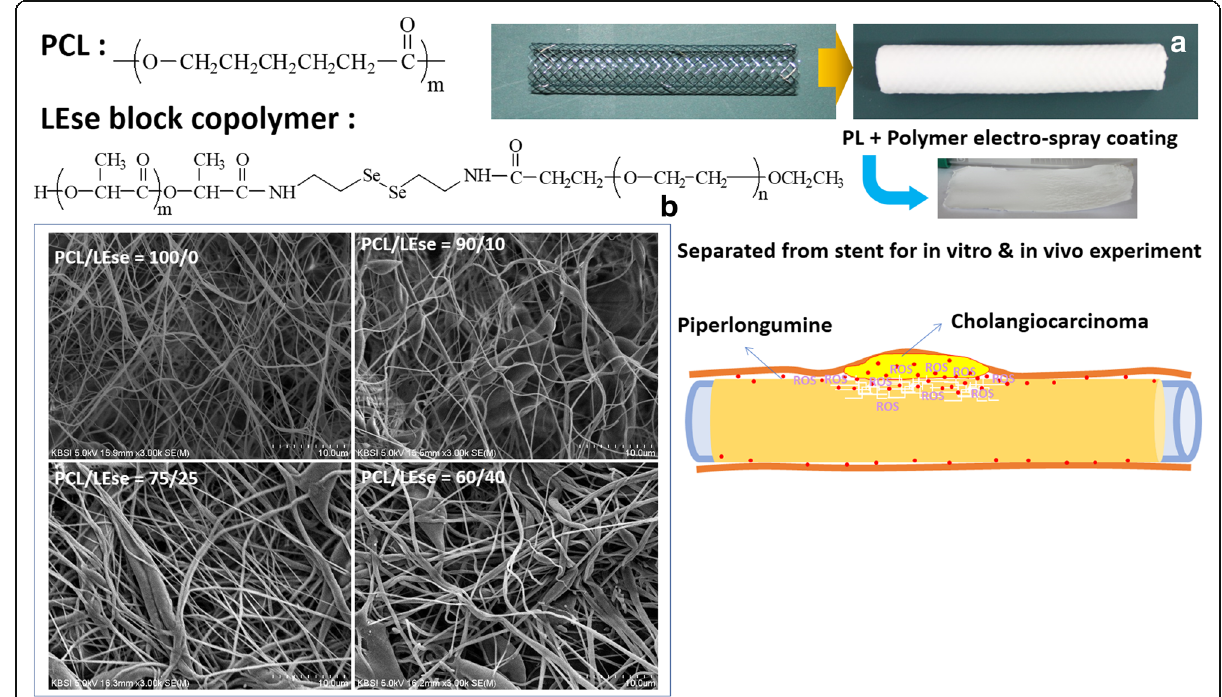
Fig. 2 a PL-incorporated nanofiber-covered GI stent. b FE-SEM photo of PL-incorporated nanofiber